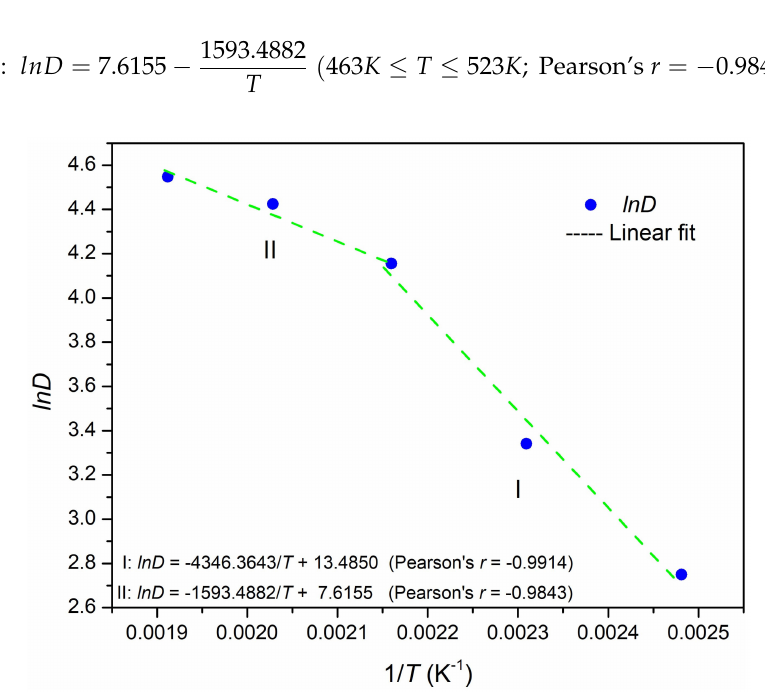
Figure 9. Natural logarithm of the percentage of dissolution ( lnD ) versus the reciprocal temperature (1/ T , K − 1 ). lnD ; — linear